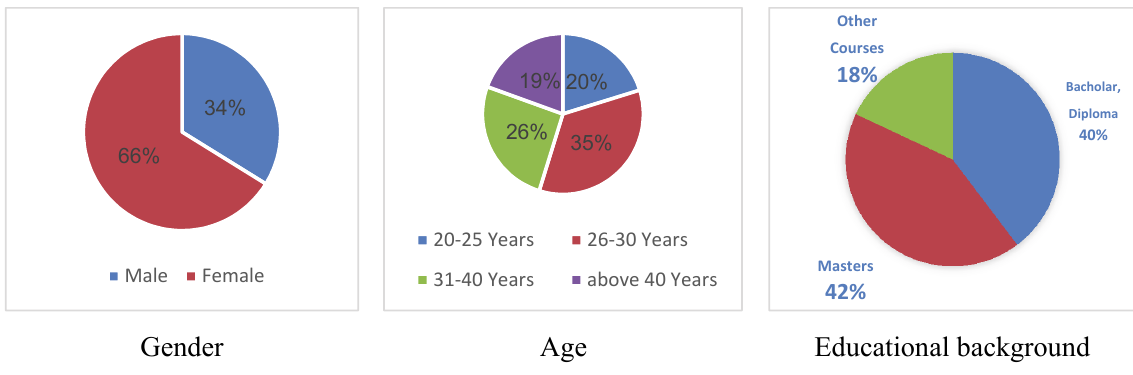
Fig. 3. Personal characteristics of the